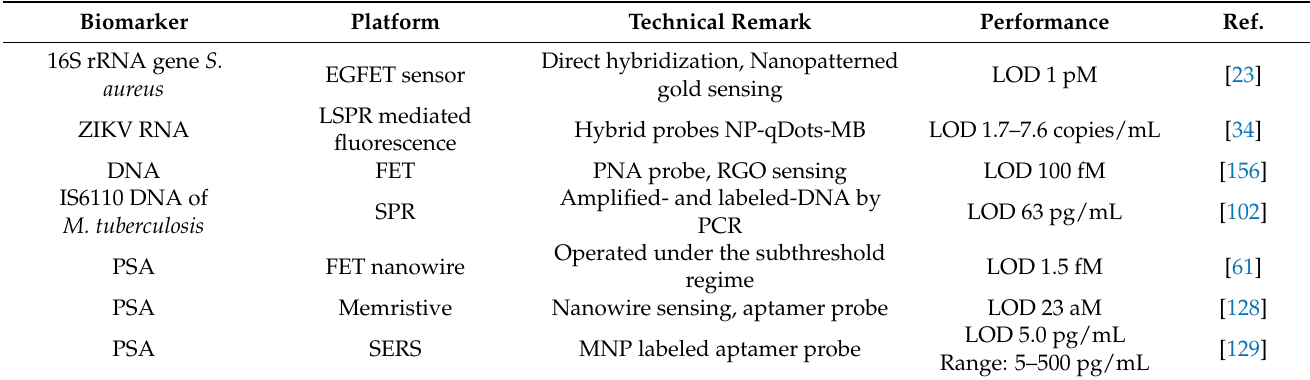
Table 5. List of biosensor studies utilizing single-biomarker detection